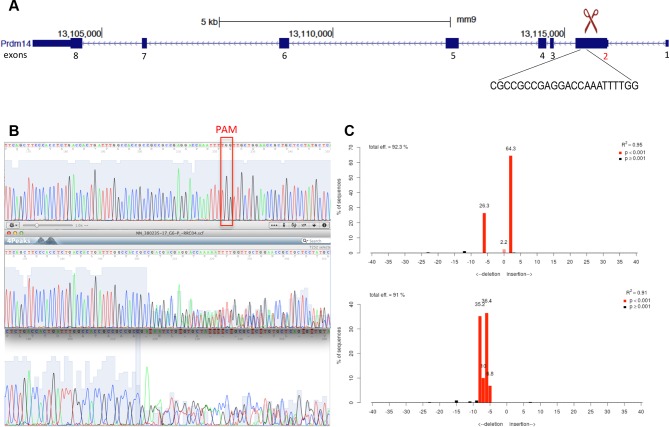
Generation of Prdm14-null line in Stella:GFP mESCs using CRISPR-Cas9 system.(A) Schematic of the Prdm14 gene and sequence of the guide RNA (http://crispr.mit.edu/). (B) Genomic and cDNA were extracted and chromatograms of the wt (top), mutant G6 line (clone 1), and mutant F10 line (clone 2) are shown. (C) Indel spectrum centered around the PAM sequence was performed using software TIDE (http://tide.nki.nl/). Clone G6 is shown on top and clone F10 below. Clones G6 and F10 produce aberrant transcript. cDNA, complementary DNA; CRISPR, clustered regularly interspaced short palindromic repeat; GFP, green fluorescent protein; mESCs, mouse embryonic stem cells; wt, wild type.